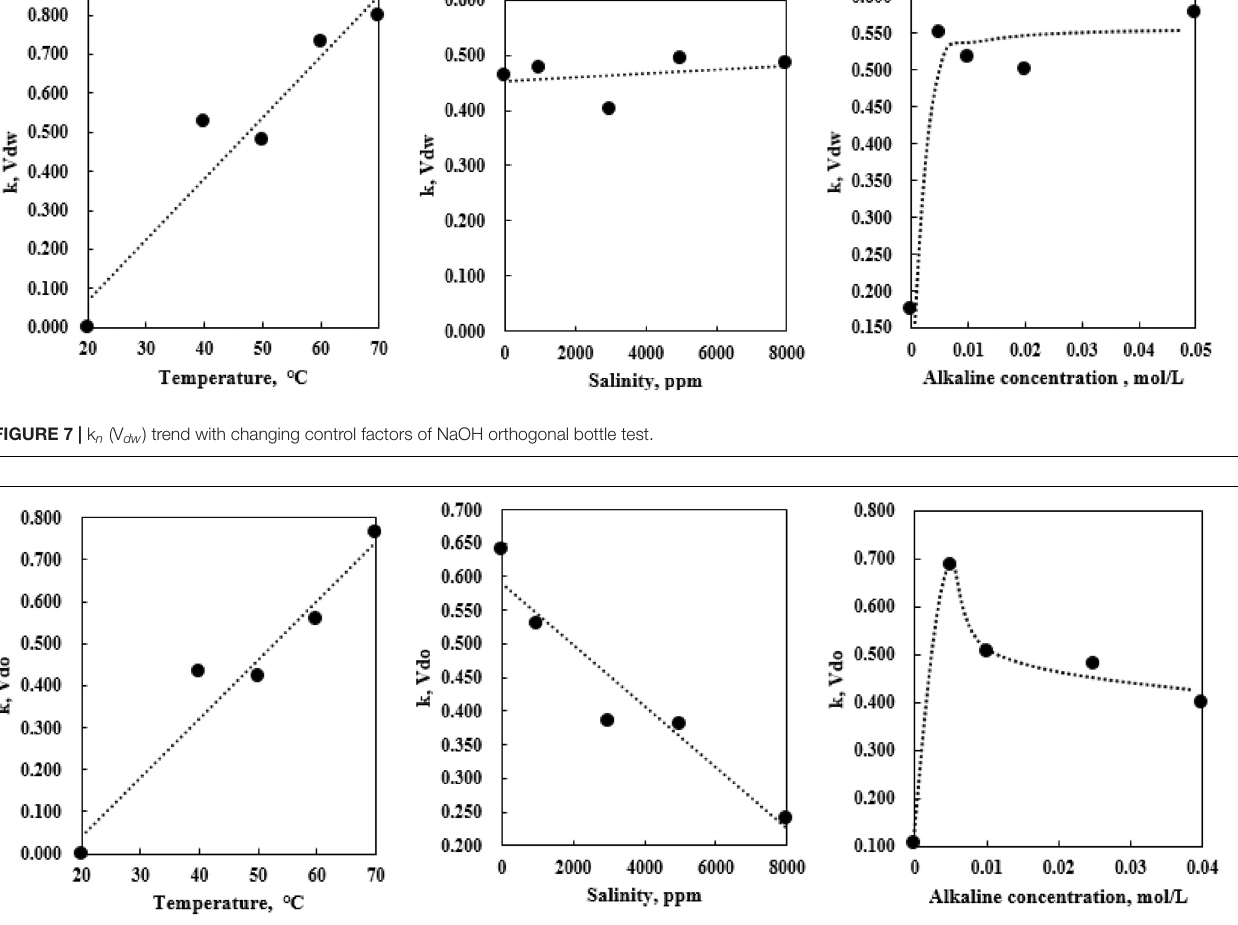
FIGURE 8 | k n (V do ) trend with changing control factors of Na 2 CO 3 orthogonal bottle